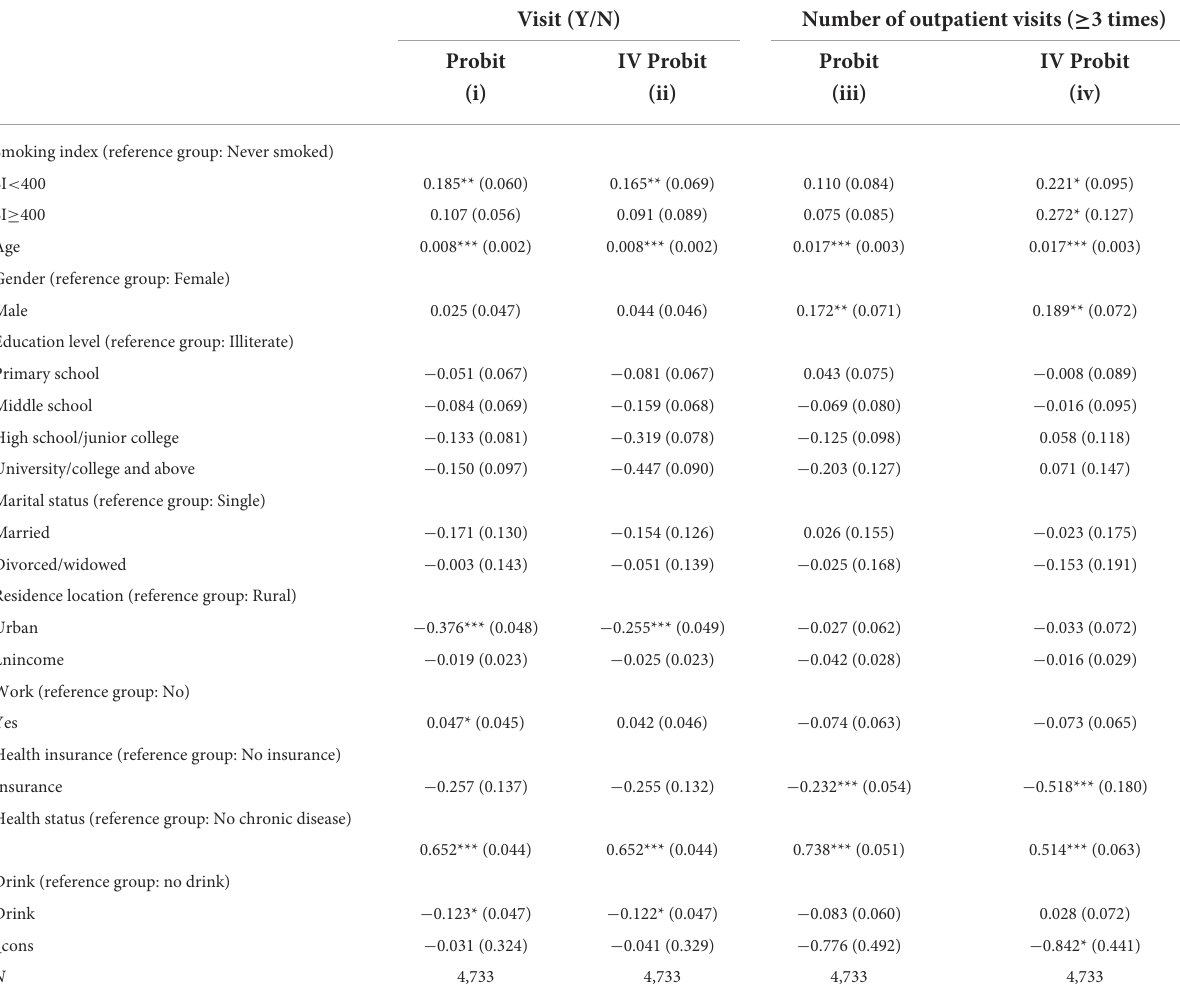
TABLE 3 Probit regression analysis and IV probit regression analysis of outpatient service